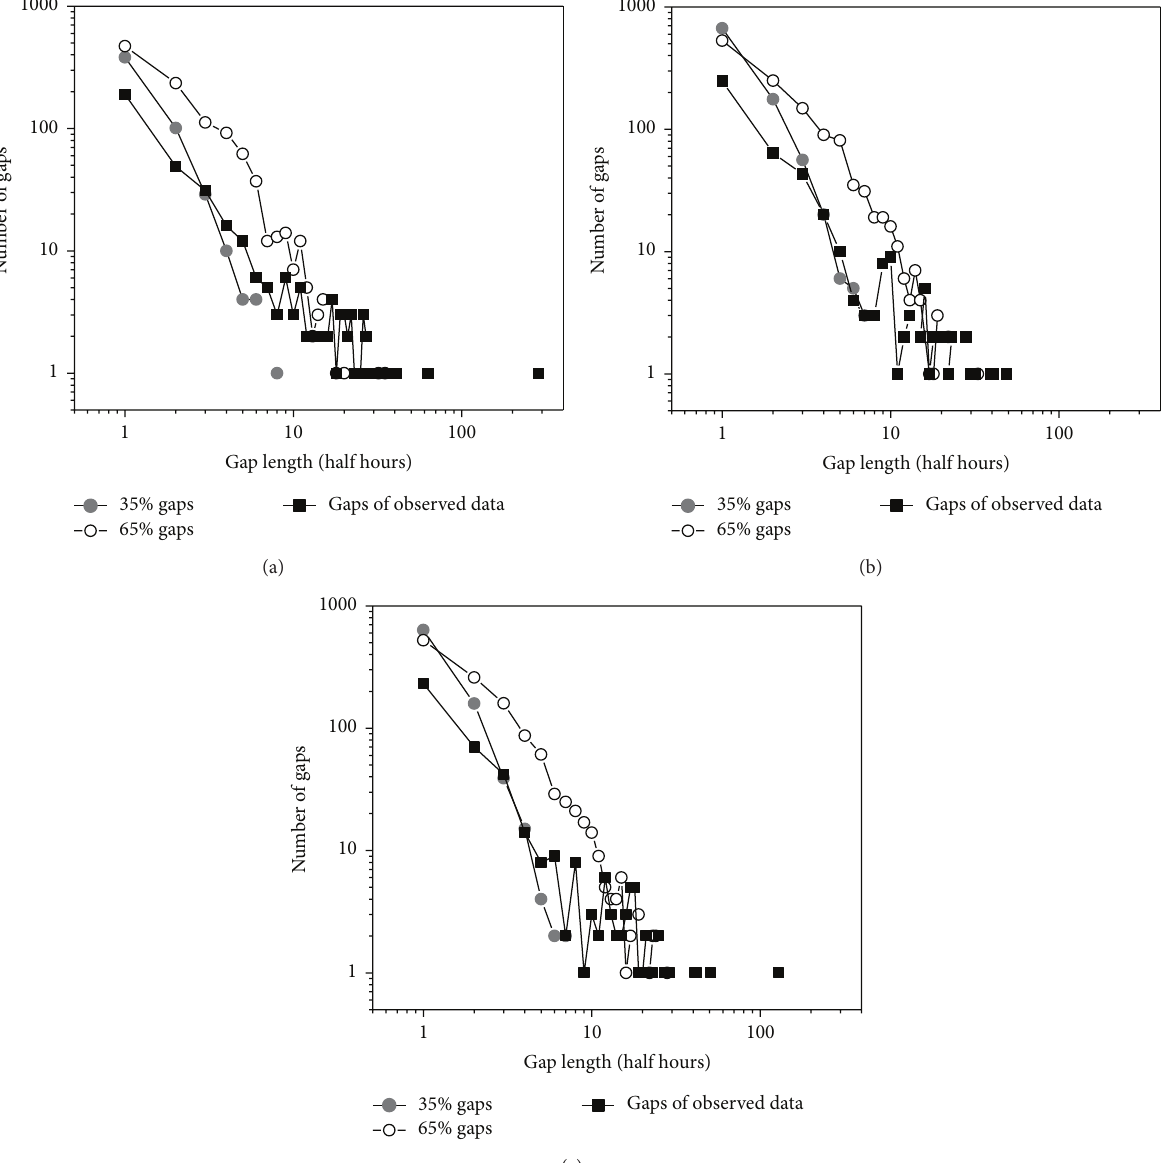
Figure 2: Frequency of gap lengths at (a) marsh, (b) rice, and (c) soybean sites. To show clearly, only frequencies of 35% and 65% gaps were plotted. The frequencies of 45% and 55% gaps were distributed between them.